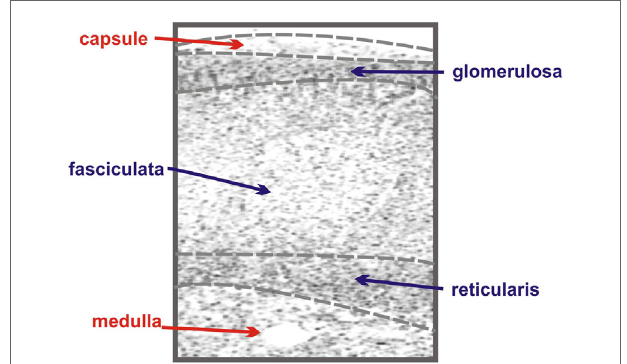
FiGURe 1 | Schematic of adrenal zonation . The different functional zones of the human adrenal gland are depicted with the outermost capsule layer overlying the mineralocorticoid-synthesizing glomerulosa layer. The fasciculata layer lies under the granulosa layer and is responsible for the synthesis of the glucocorticoid cortisol. The final layer of the cortex, the reticularis, synthesizes the androgen dehydroepiandrosterone (DHEA), while the innermost layer of the schematic, the medulla, is composed of chromaffin cells, responsible for the production of the catecholamine epinephrine.